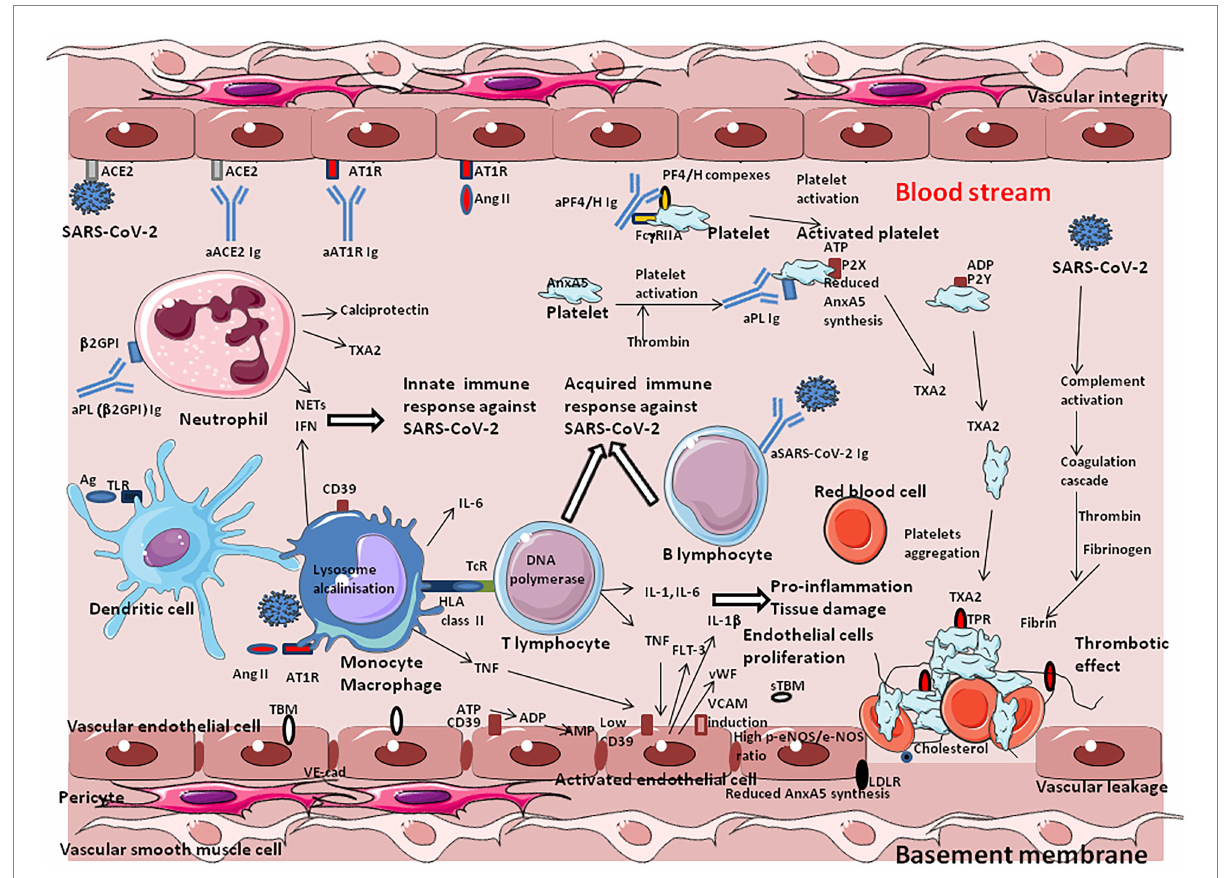
FIGURE 8 Under physiological conditions, the vascular endothelium, composed of vascular endothelial cells (VECs), functions as an integral barrier with intercellular junctions ensured by adhesion molecules such VE-cadherin. It maintains blood fluidity by acting as an anticoagulant through the suppression of platelet activation and the induction of fibrinolysis, a mechanism including heparan sulfate proteoglycans and CD39. During SARS- CoV-2 infection, innate and acquired immune defense mechanisms are activated with the overproduction of cytokines such as IL-1, IL-2, IL-6, IL-8, IL-17, and TNF α (a phenomenon known as the “cytokine storm”), which disrupts blood vessel walls and provokes tissue damage in the lung parenchyma and the immediately adjacent bronchial alveolar lymphoid tissue. The endothelial cells express the ACE2 molecule that acts as a cell-surface-receptor, facilitating SARS-CoV-2 entry into these cells. The SARS-CoV-2 induced increased concentrations of Ang II have mild platelet-activating effects, thereby enhancing coagulation and are also associated with monocyte and macrophage accumulation, which produces proinflammatory cytokines and worsen hypertension. When blood vessels are strained due to high blood pressure, the endothelial cells of the blood vessels are damaged, and the function of the endothelium at preventing arteriosclerosis is lost. When activated by proinflammatory cytokines, or neutrophil extracellular traps, endothelial cells produce von Willebrand factor, which retains platelets and leucocytes to the vessel wall and activates coagulation systems resulting in the rapid activation of mechanisms leading to the repair of local damage, the accumulation of immune cells to prevent infection, and the aggregation of platelets for primary and secondary hemostasis. Anti-PF4/polyanion (heparin) complex immunoglobulins directly activate platelets via their Fc gamma type 2 receptor A (Fc γ RIIA). The hyper-reaction set up in response to vascular damage, can influence a propensity toward local vascular micro-thrombosis. COVID-19 patients suffer from prominent alveolar oedema, intra- alveolar proteinosis, cell infiltration (including lymphocytes), apoptosis of virally-infected pneumocytes, and fibrin deposition. aPL, antiphospholipids immunoglobulins; aACE2 Ig, anti-ACE2 immunoglobulins; aAT1R Ig, anti-AT1R immunoglobulins; aPF4/H Ig, anti-PF4/heparin immunoglobulins; AnxA5, annexinA5 (or annexin V or anchorin CII; anticoagulant, interact with phospholipids); Ag, antigen; Ang II, angiotensin II; AT1R, angiotensin II receptor type 1; IFN, interferon; CD39/ENTPD1, ectonucleoside triphosphate diphosphohydrolase-1 (also known as P2 receptors: P2X receptors are ion channels that open upon binding of ATP; P2Y receptors mediate cellular response to purine and pyrimidine, such as ATP, ADP, and UTP; in physiological conditions CD39 catalyzes the reduction of ATP and ADP pool to AMP and CD73 transform AMP to adenosine whereas nucleotides released during cell activation/injury bind to P2 receptors to activate thrombo-inflammatory programs); IL-6, interleukin-6; LDLR, low density lipoprotein receptor (bind LDL/cholesterol); NETs, neutrophil extracellular traps; TcR, T-cell receptor; TLR, toll like receptor; TNF, tumor necrosis factor; TXA2, Thromboxane A2 (induce platelets aggregation); TPR, thromboxane A2 prostanoid receptor: VE-cad, VE-cadherin; TBM, thrombomodulin prevents thrombosis; upon endothelial cell activation a soluble form of TBM (sTBM) is released in plasma further promoting procoagulant mechanisms. VWF, von Willebrand factor; Fibrin, fibrin is formed from blood plasma fibrinogen (produced in the liver) by the action of thrombin; red thrombus is composed of erythrocytes enmeshed in a fibrin